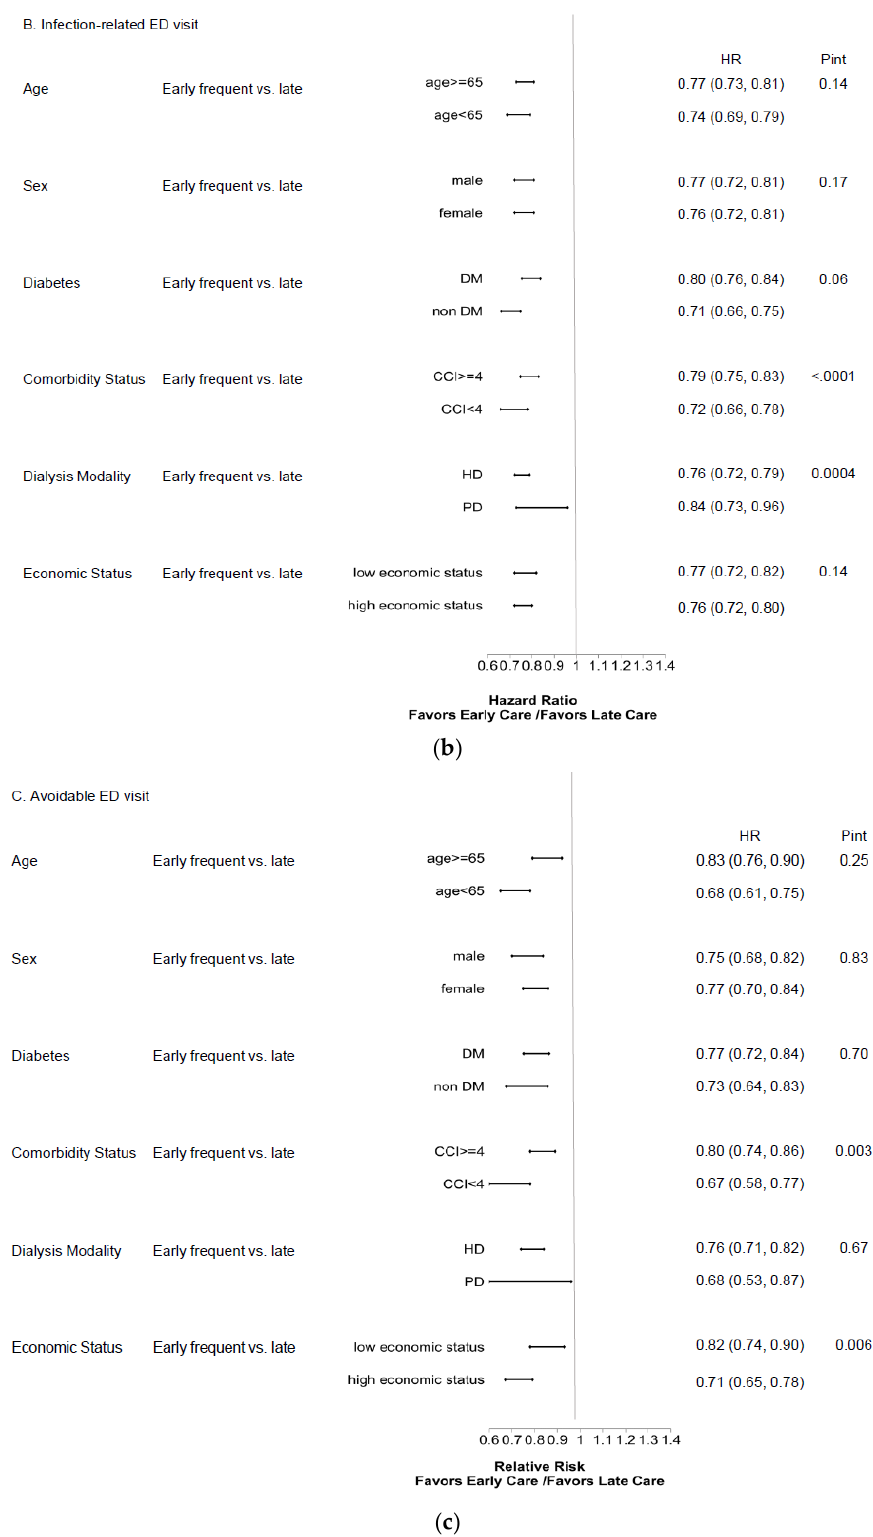
Figure 2. Subgroup analysis of hazard ratio for 1-year ED visit between the early-frequent and late-nephrology-care groups for first event of ( a ) all-cause, ( b ) infection-related, and ( c ) potentially avoidable ED visit. Abbreviations: ED, emergency department; CCI, Deyo’s Charlson Comorbidity Index; DM, diabetes mellitus; HD, hemodialysis; HR, hazard ratio; PD, peritoneal dialysis; Pint, p value for interaction